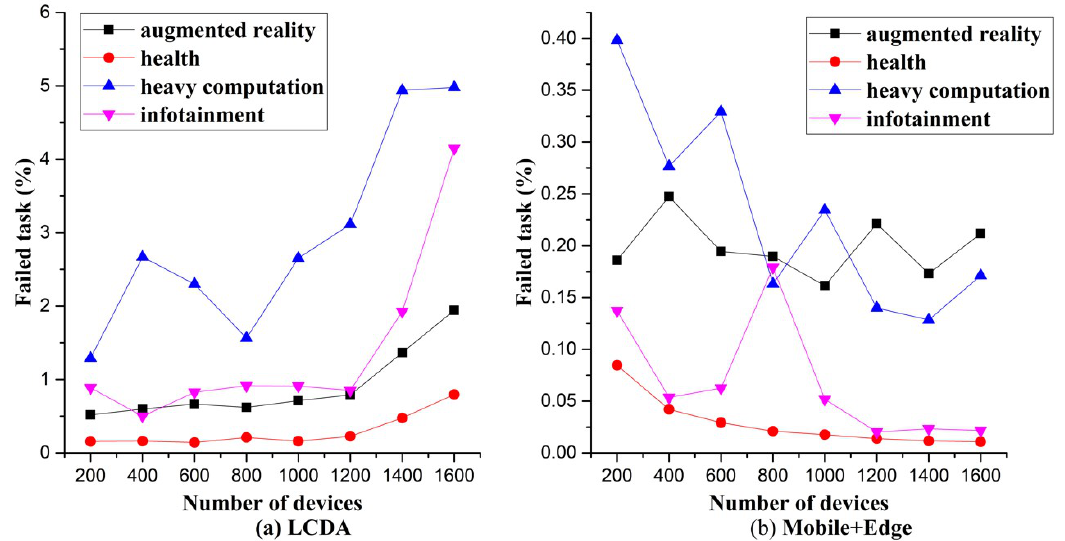
Figure 8. Performance comparison of the failed task rate for different application types.